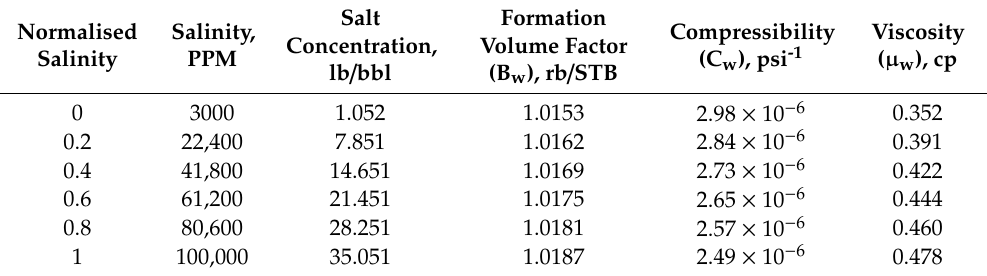
Table 1. An illustration of the brine properties using an increment step of 20% in the normalised salinity. The table is based on a maximum salinity of 100,000 ppm and a minimum of 3000 ppm, using a linear formula and the conditions of the Qamchuqa reservoir. This table (except Columns 1 and 2) is utilised in the simulation model to calculate the brine properties in the mixing